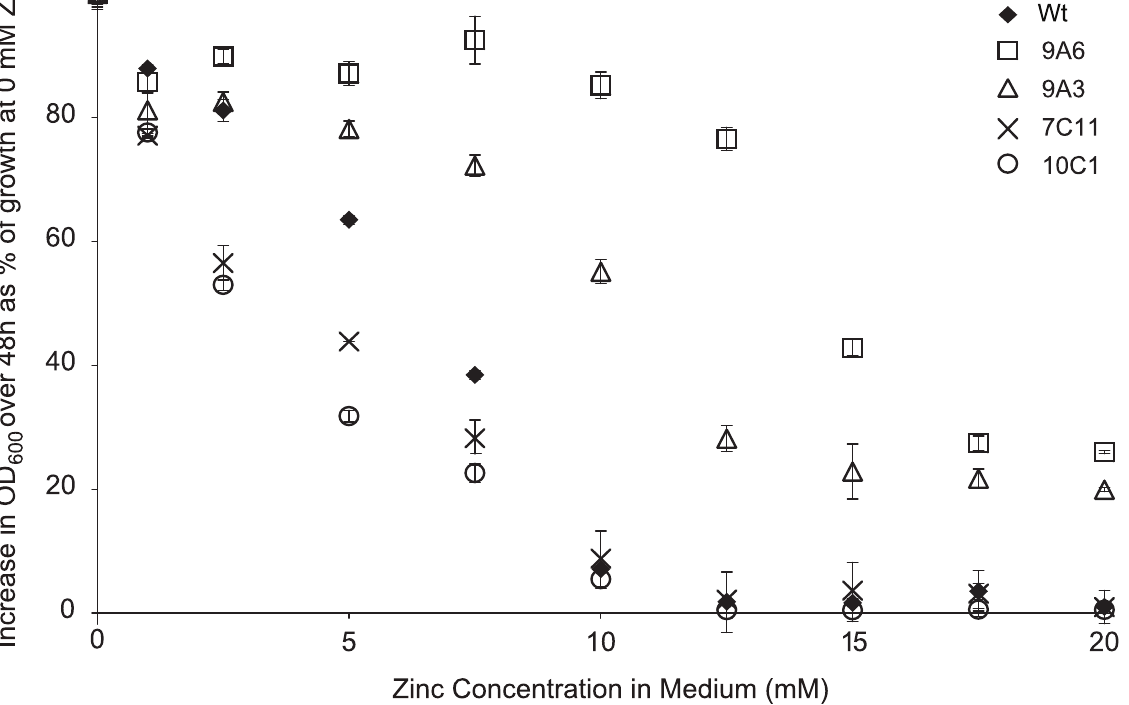
Table 2. P. syringae pv. maculicola M4 mutants with altered zinc tolerance.